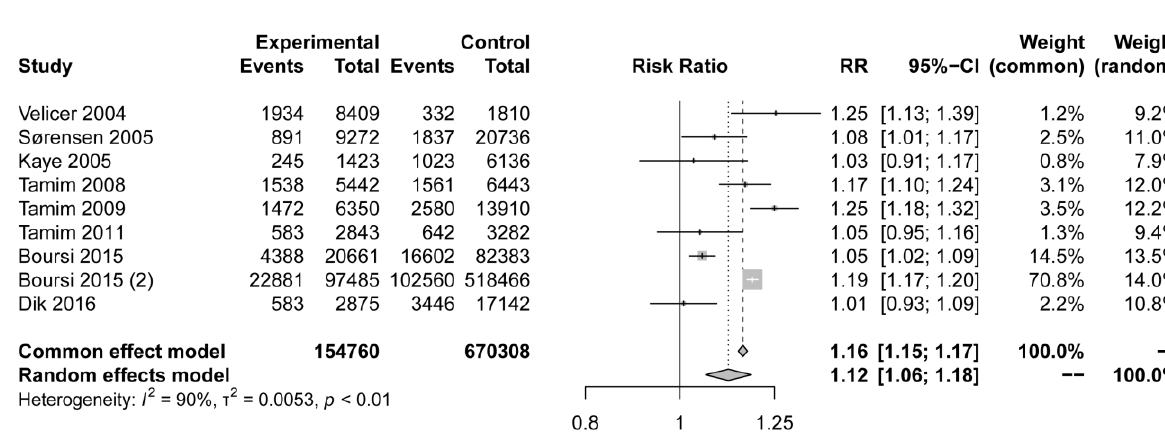
FIGURE 1: Forest plot examining the association between macrolide antibiotic ever-use versus nonuse and the risk of